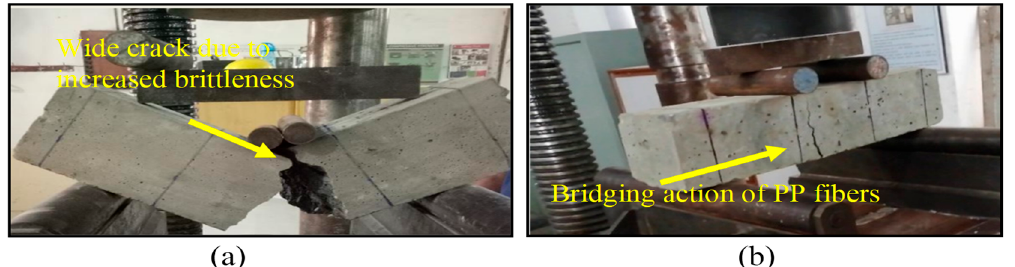
Figure 8. The fracture pattern of concrete specimens in the performance of test for flexural strength. ( a ) In control and steel slag concrete specimens, sudden failure at peak load was seen. ( b ) In fiber-